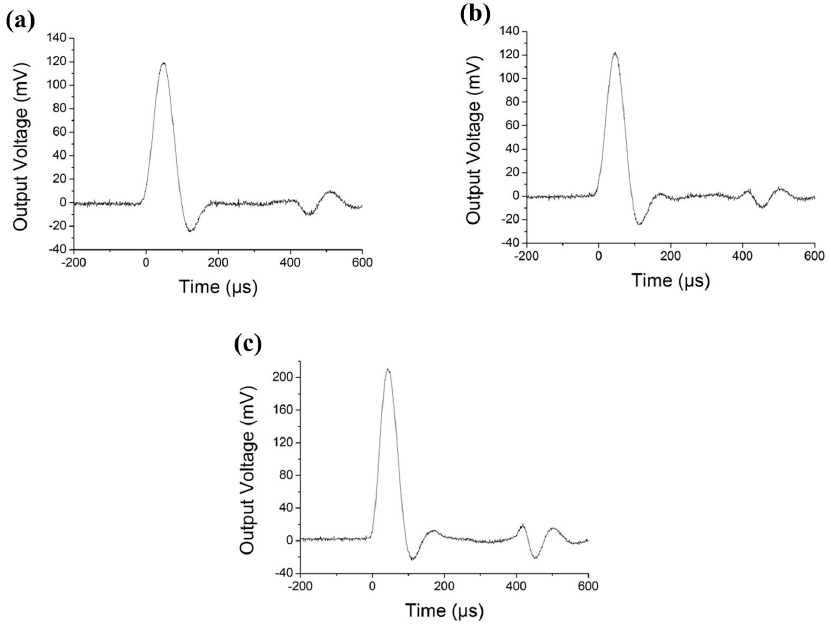
Figure 7. High-shock testing results by dropping the steel-bars from a height of 25 cm. ( a–c ) show the